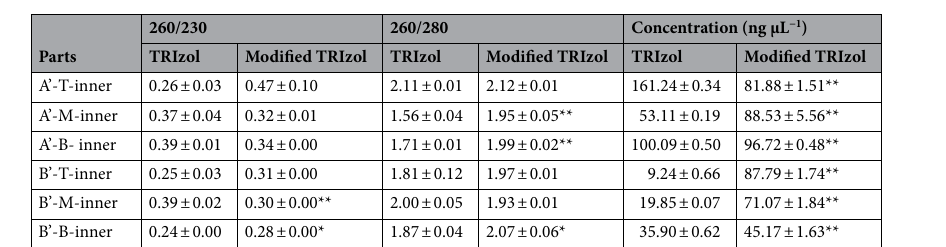
Figure 4. Gel images of total RNA from external scales of Lilium davidii var. unicolor isolated using different protocols. The RNA samples extracted by the modified TRIzol method ( A ), Kit method ( B ) and CTAB method ( C ) were separated and analyzed in 1% agarose gels, respectively. Then the gels were visualized and exposed by Gel Imager System in different fields, andpictures were taken, respectively. The order of samples of each gel lane is as follows: Lane 1: DL2000 DNA marker; Lanes 2–4 are RNA isolated from top scales of Lilium ; Lanes 5–7 are RNA isolated from middle scales of Lilium ; Lanes 8–10 are RNA isolated from basal scales of Lilium ; Lane 11: Loading buffer solution without RNA to serve as a control. 28S and 18S represent the location of 28S and 18S rRNA bands.